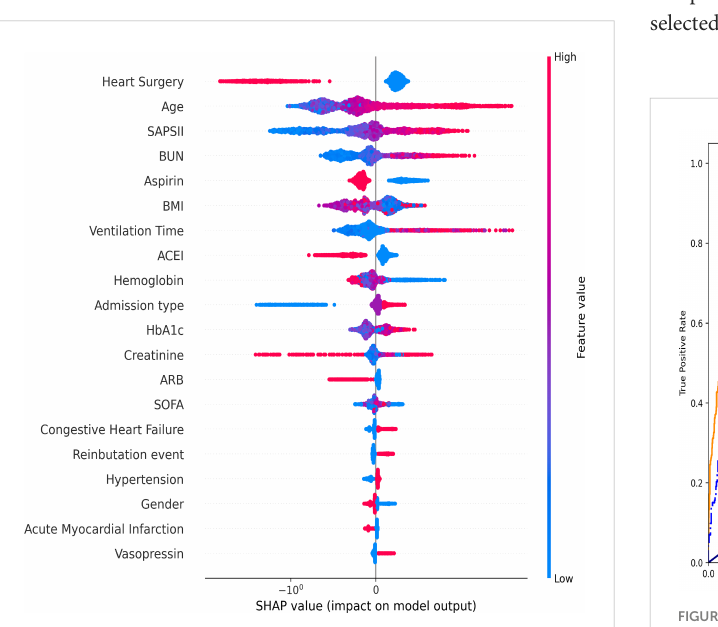
FIGURE 4 The SHAP values of variables in the XGBoost machine learning model.